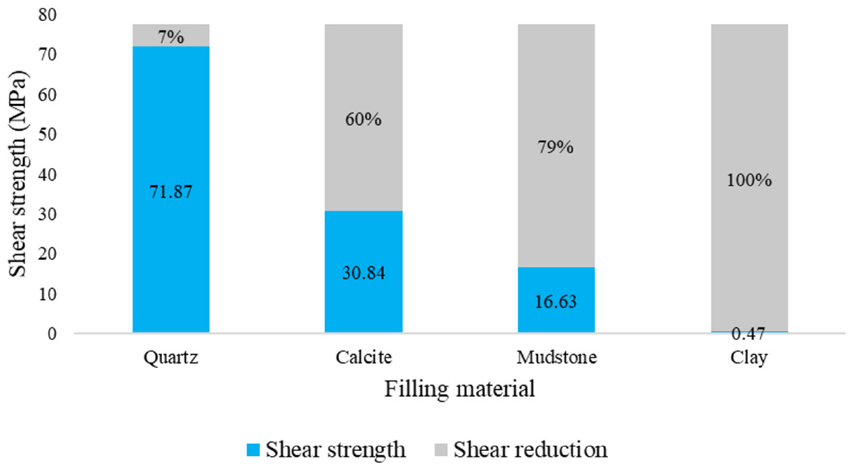
Figure 17. Effect of infilled mineral on the peak shear strength of rock specimens.